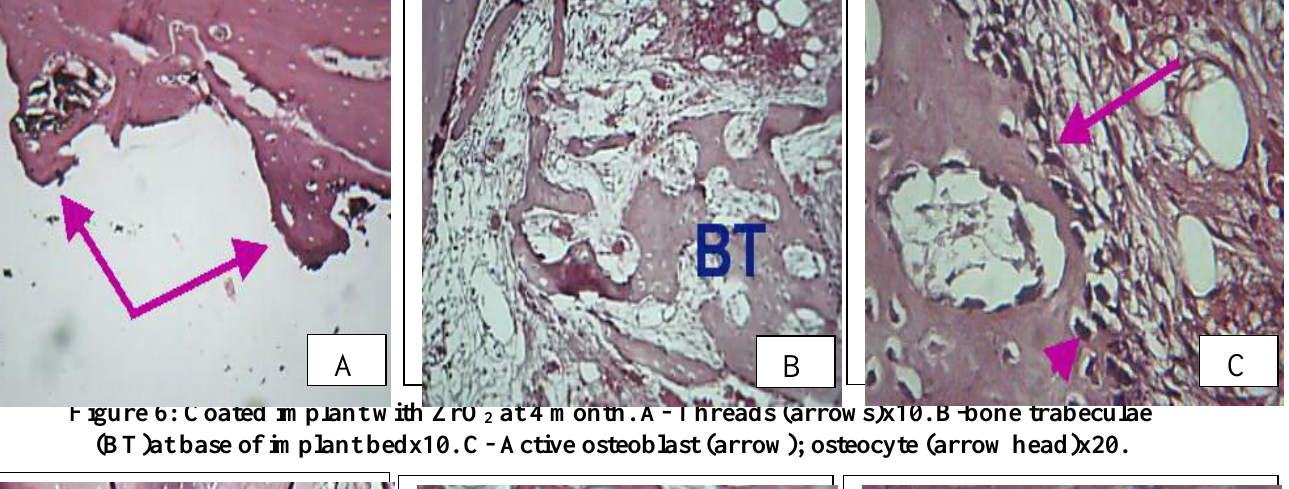
Figure 6: Coated implant with ZrO at 4 month. A- Threads (arrows)x10. B-bone trabeculae 2 (BT)at base of implant bedx10. C- Active osteoblast (arrow); osteocyte (arrow head)x20.